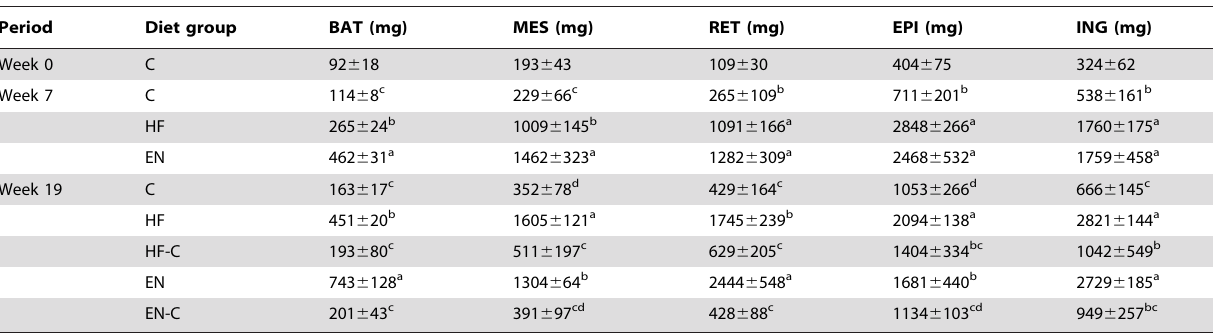
Table 2. Fat pad